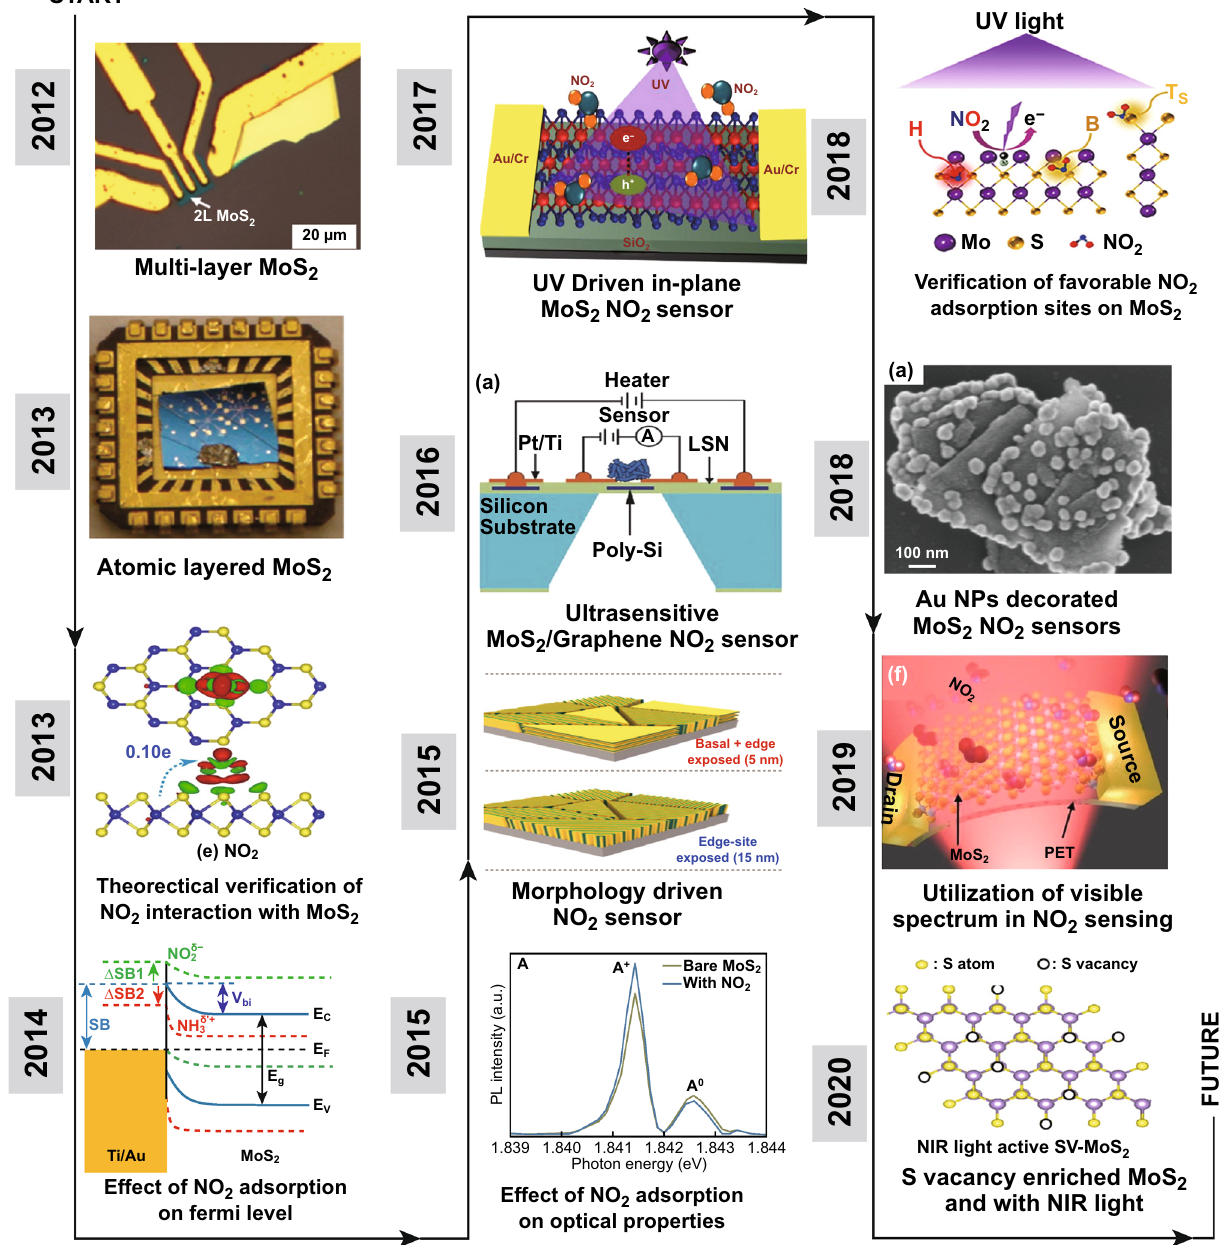
Fig. 1 Schematic representation of the 8-year journey of MoS 2 -based NO 2 sensors. Reproduced with permission from Refs. [34, 118]. Copy- right @ Wiley-VCH; Refs. [17, 32, 35, 36, 119, 120, 123]. Copyright @ American Chemical Society; Ref. [117]. Copyright @ Springer;